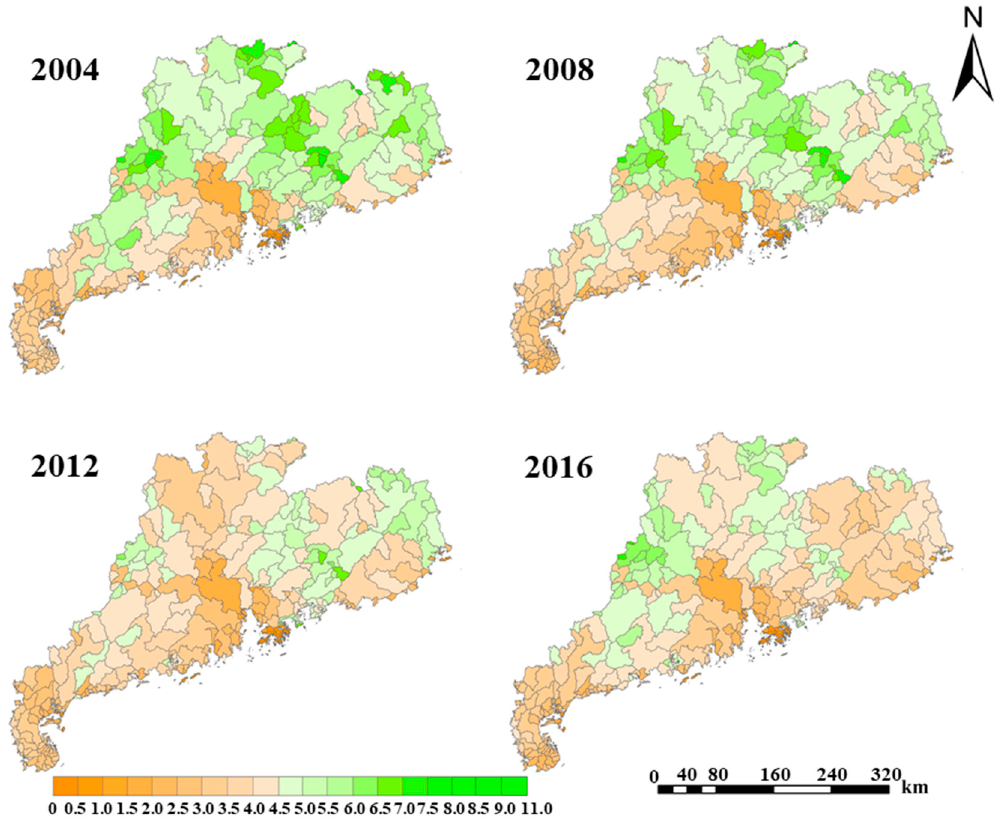
Figure 8. Spatial patterns of annual mean CRIRs in Guangdong.